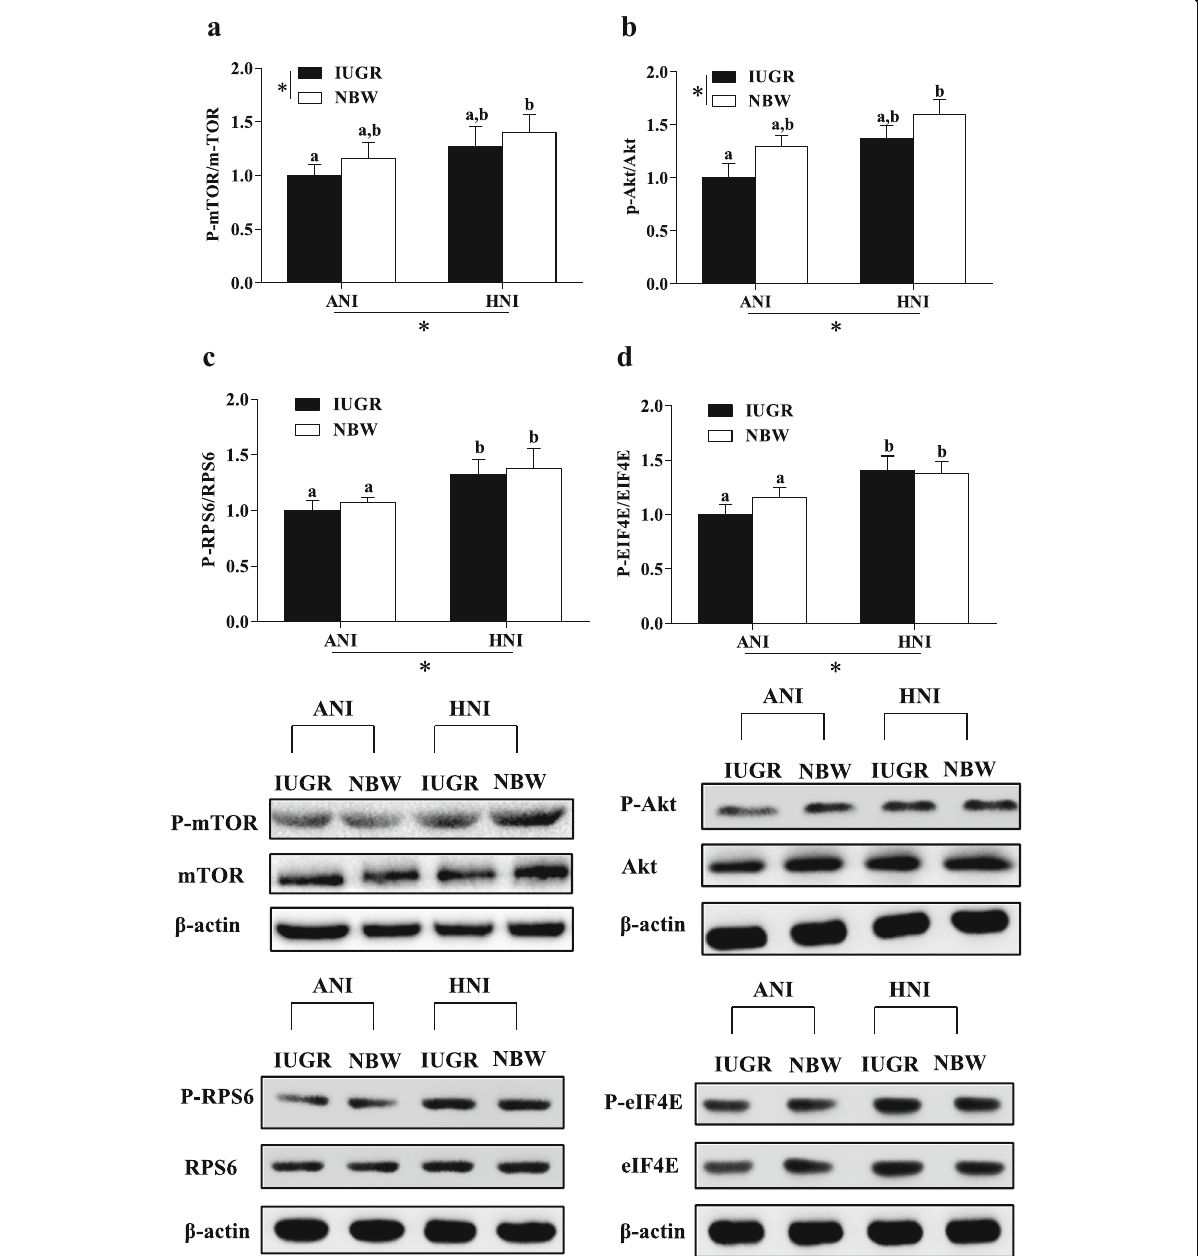
Fig. 4 Effects of the level of nutrient intake on abundance of growth-related proteins in psoas major muscle of pigs with different birth weight. ANI , adequate nutrient intake; HNI , high nutrient intake; IUGR , intrauterine growth restriction; NBW , normal birth weight; mTOR , mammalian target of rapamycin; p-mTOR , phosphorylated mTOR; Akt , protein kinase B; P-Akt , phosphorylated Akt; RPS6 , ribosomal protein S6; P-RPS6 , phosphorylated RPS6; eIF4E , eukaryotic translation initiation factor 4E; P-eIF4E , phosphorylated eIF4E. Values are means, with their standard errors represented by vertical bars ( n = 6 for each group). Mean values with different letters (a, b) were significantly different between four groups ( P < 0.05). * P < 0.05 for the respective sources of variation (nutrition intake or body